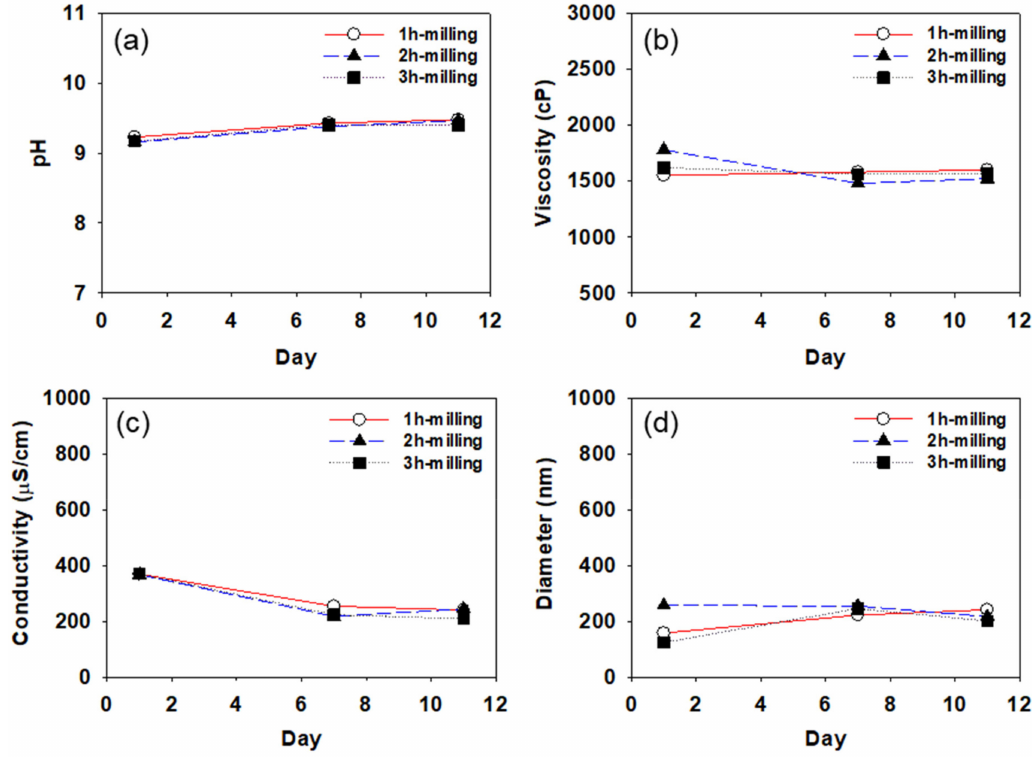
Figure 7. Variation of pH ( a ), viscosity ( b ), conductivity ( c ), and particle diameter ( d ) with time measured for the CB dispersions prepared using